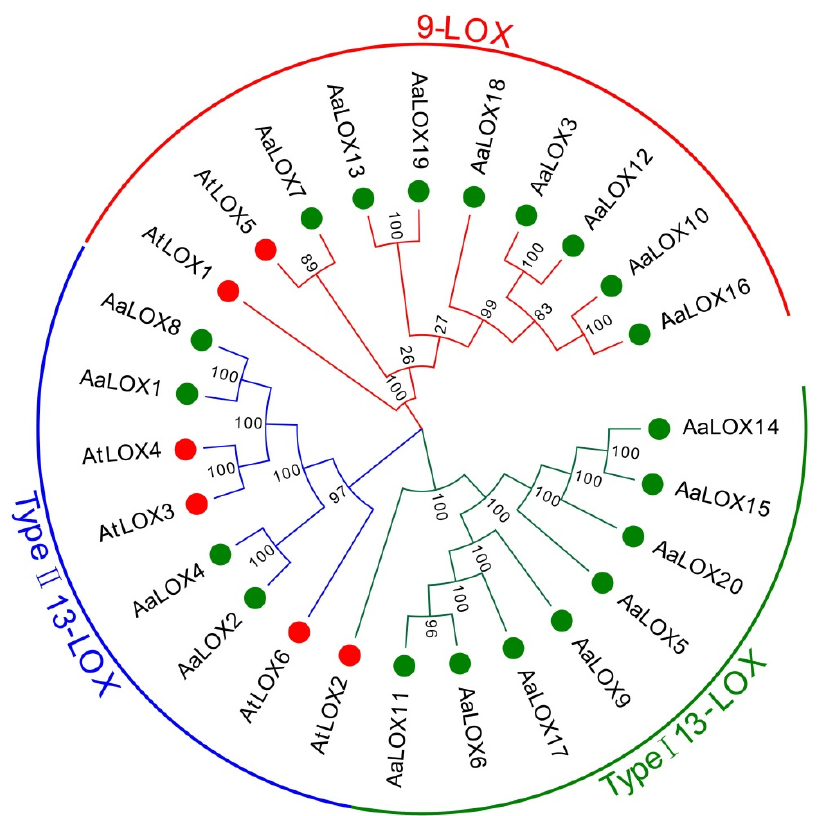
Figure 2. Phylogenetic analysis of LOX genes from A. annua and A. thaliana . Gene classes are indicated by different colors. Taxon labels are depicted in red for the 9-LOX clade, in blue for type II 13-LOX clade, and in green for type I 13-LOX clade. Members of LOX protein from A. annua are denoted by a green dot.